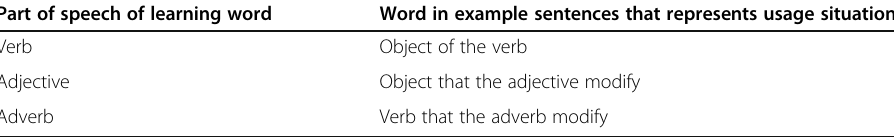
Table 1 Words that represent usage situation according to the part of speech of learning